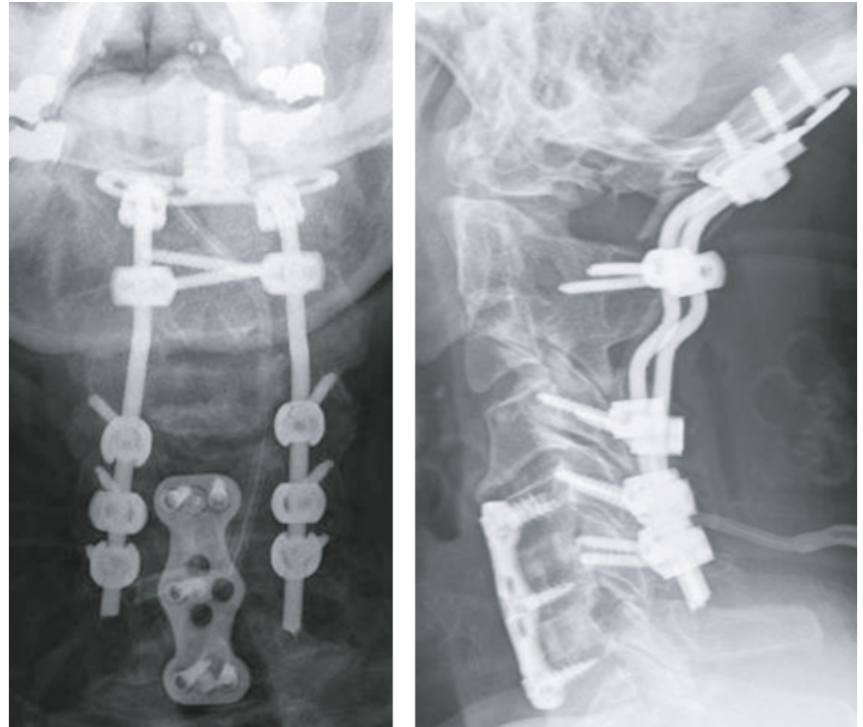
Figure 2: Case 1: postoperative X-ray. Occipito-C6 PSIF.